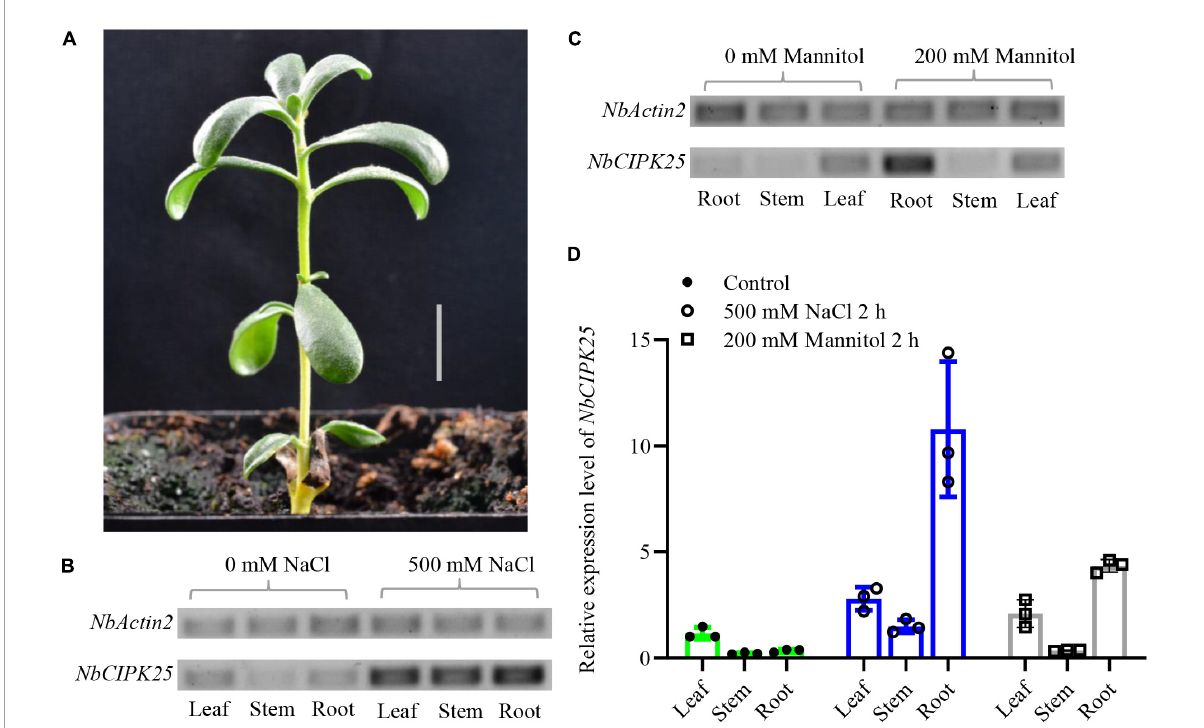
FIGURE4 Stress-induced NbCIPK25 expression in different tissue of N. billardieri . (A) Morphology of N. billardieri seedlings used for transcription level analysis of NbCIPK25 under salt and drought treatment. Scale bar: 1 cm. (B,C) NbCIPK25 expression was tested by semi-qPCR in the indicated tissues of N. billardieri exposed to 500 mM NaCl (B) and 200 mM mannitol for 2 h (C) . (D) NbCIPK25 expression tested by qPCR in the indicated tissues of N. billardieri exposed to 500 mM NaCl and 200 mM mannitol for 2 h. Data represent the means ± SD, three biological